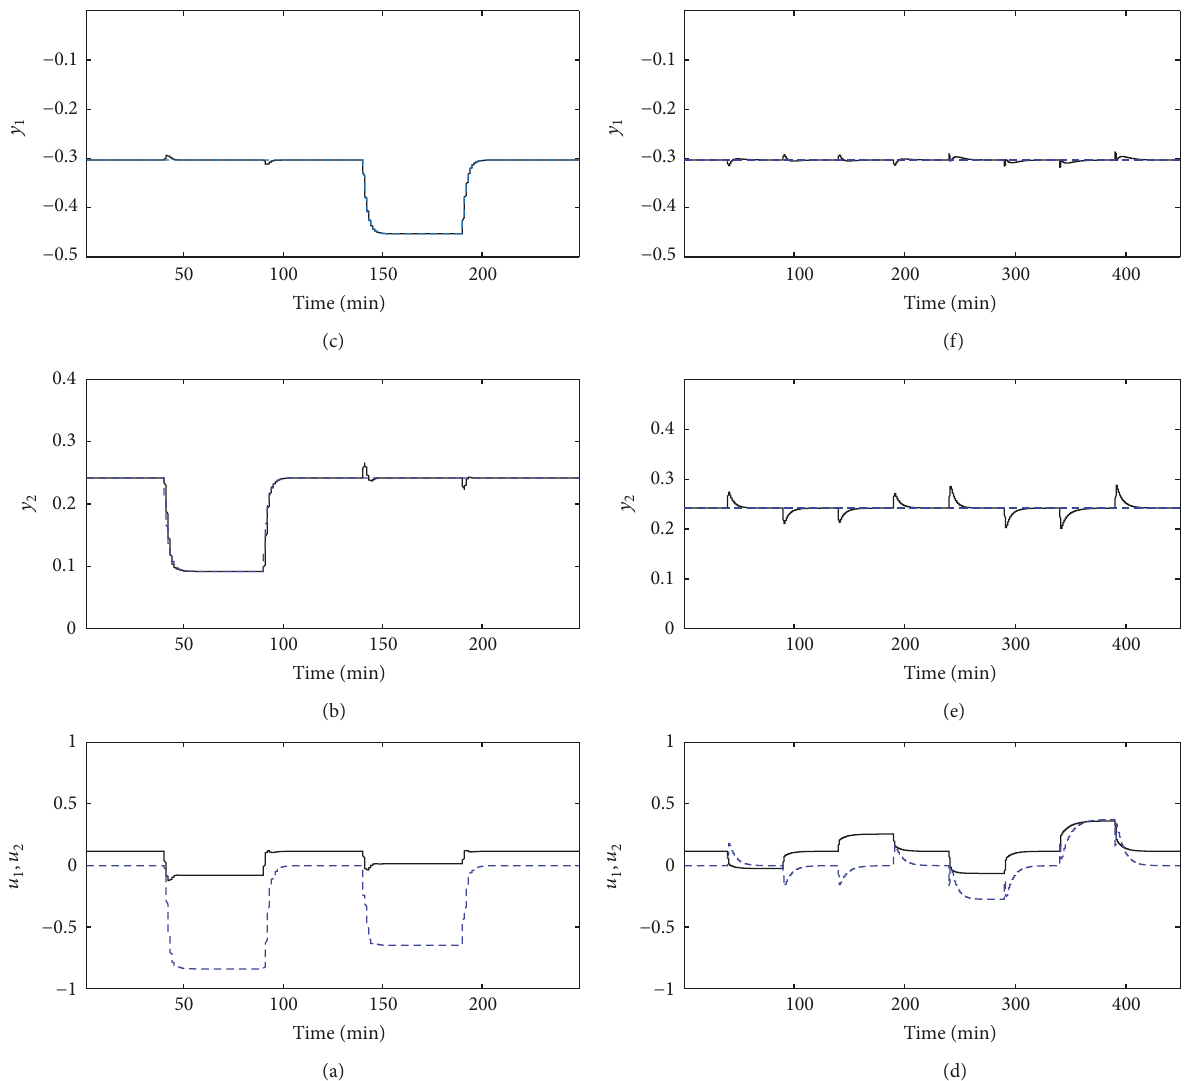
Figure 5: Performance of the gain-scheduling PI in Case 2: (a)–(c) Set-point tracking tests; (d)–(f) disturbance rejection tests. Set-points: dashed blue line; system responses: black line; 𝑢 1 : black line; 𝑢 2 : blue dashed line.